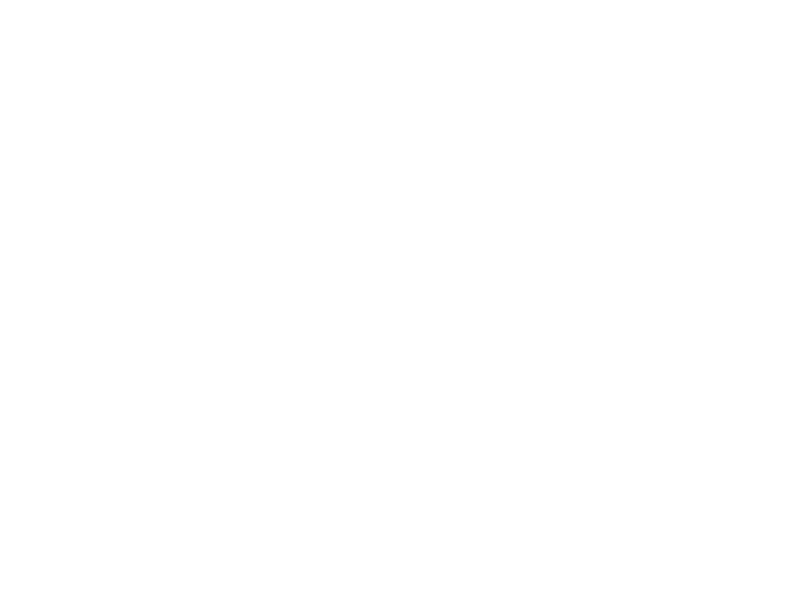
FIG. 2. Relationships between plasma TNF- a and IL-10 concentrations in normal children and CF patients. Multiple regression analysis has been performed. IL-10 and TNF- a were supposed as dependent and independent parameters, respectively. (A) In the case of TNF- a /IL-10 > 1 (immune quiescence), plasma cytokine concentration correlated with regression lines, which were described by the equations: IL-10 = 0.76 ´ TNF- a – 0.21 (line 1, normal children before vaccination) and IL-10 = 0.27 ´ TNF- a + 0.45 (line 2, CF patients). (B) Under TNF- a /IL-10 < 1 (immune disturbance), regression models are described by the equations: IL-10 = 2.20 ´ TNF- a + 1.28 (line 3, normal children 1 month after vaccination) and IL-10 = 1.53 ´ TNF- a – 0.07 (line 4, CF patients). The encircled point demonstrates a spike in IL-10 plasma level of subject number 6 (see